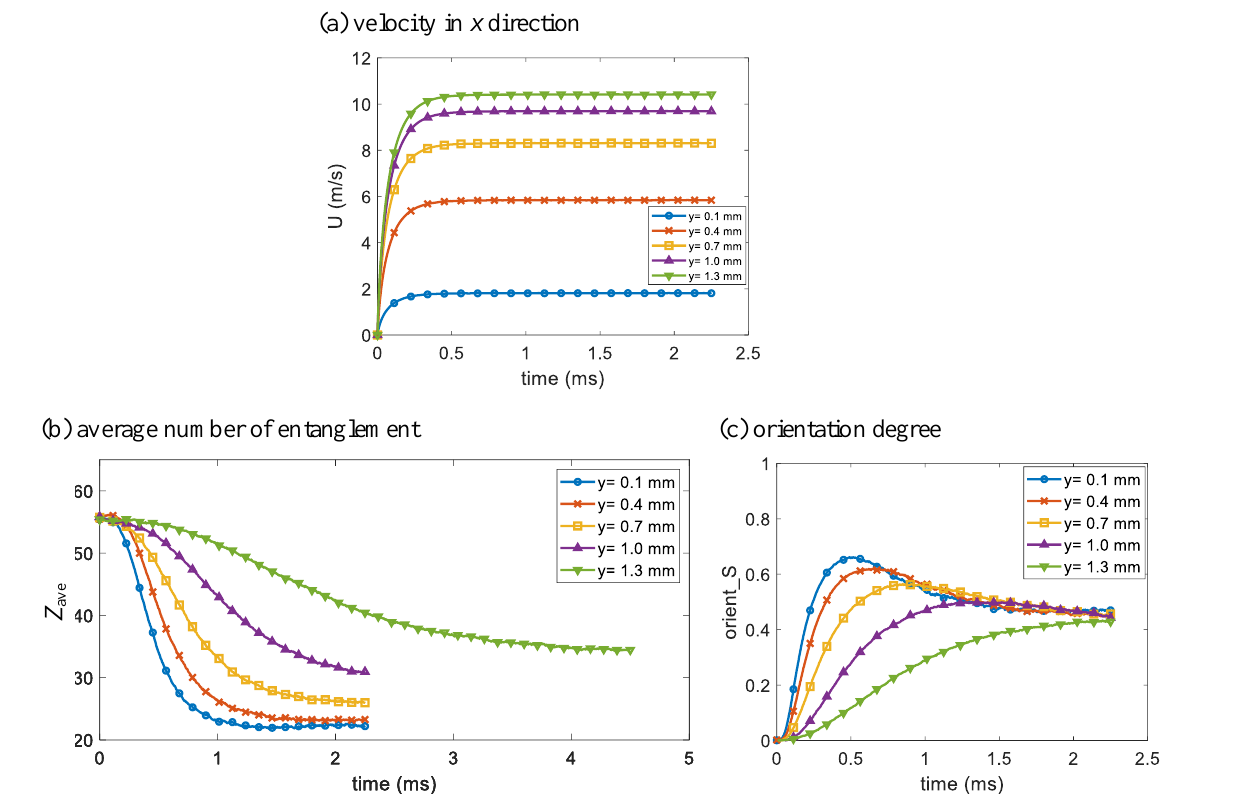
Figure 4. The multiscale simulation results of changes in ( a ) velocity in x direction, ( b ) average number of entanglements and ( c ) orientation degree over time of Poiseuille flow at different y coordinates as indicated.